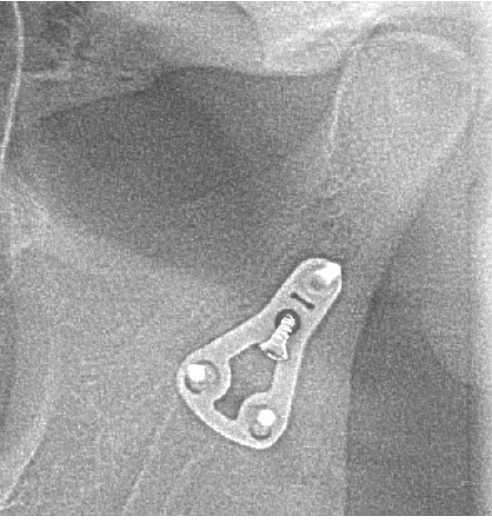
Figure 13. Patient B—A case complicated by screw loosening—immediately after open reduction internal fixation. J. Clin. Med. 2020 , 9 , x FOR PEER REVIEW